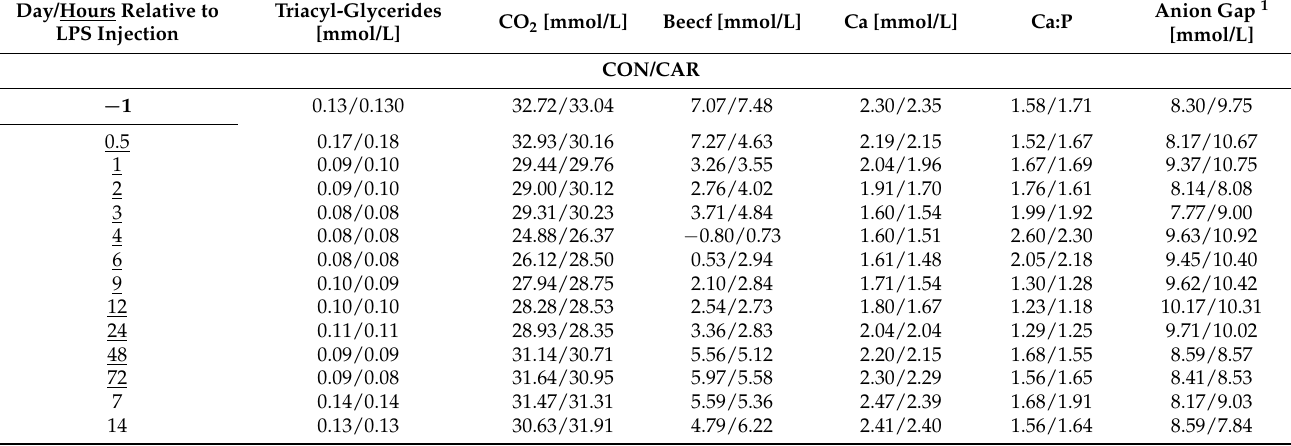
Table A5. Effects of L -carnitine supplementation on concentration of triacyl-glycerides, total carbon dioxide (CO 2 ), base excess in extracellular fluid compartment (Beecf), total calcium (Ca), ratio of total calcium and total phosphorus (Ca:P) and anion gap of German Holstein cows challenged by an intravenous injection of lipopolysaccharides (LPS, 0.5 µ g/kg BW) at time point